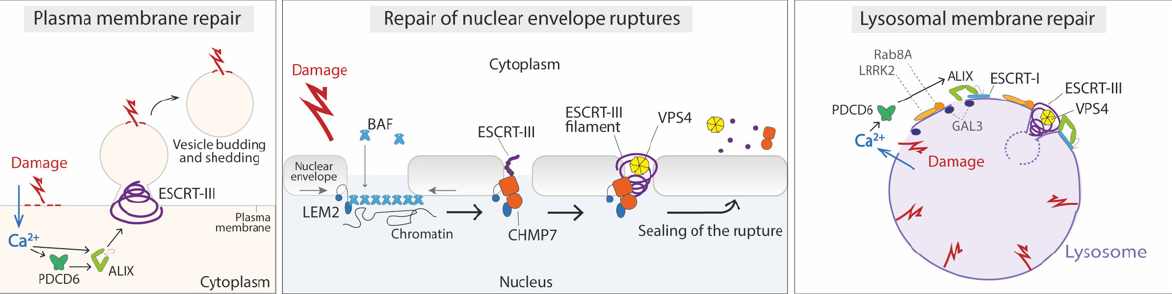
Figure 3. Membrane repair processes mediated by ESCRT. Left panel: plasma membrane repair. Entry of calcium through the damaged membrane triggers rapid ESCRT recruitment, mediated by PDCD6 and ALIX. ESCRTs are thought to promote membrane budding and shedding of small do- mains containing the site of damage; middle panel: nuclear envelope (NE) repair. Upon NE rupture, cytosolic BAF coats the exposed chromatin and interacts with LEM2, facilitating the recruitment of nuclear membrane and the interaction with CHMP7. CHMP7 subsequently promotes the nucleation and polymerization of ESCRT-III, which together with VPS4 constricts the rupture and promotes sealing; right panel: lysosome repair. After damage, calcium efflux from the lysosome promotes ESCRT-I and -III recruitment through PDCD6, ALIX, and probably other factors like GAL3 and LRRK2, which phosphorylate the small GTPase Rab8A. It is thought that the membrane-remodeling performed by ESCRT-III filament spirals acts to shed damaged membranes into the lumen of the lysosome for recycling.